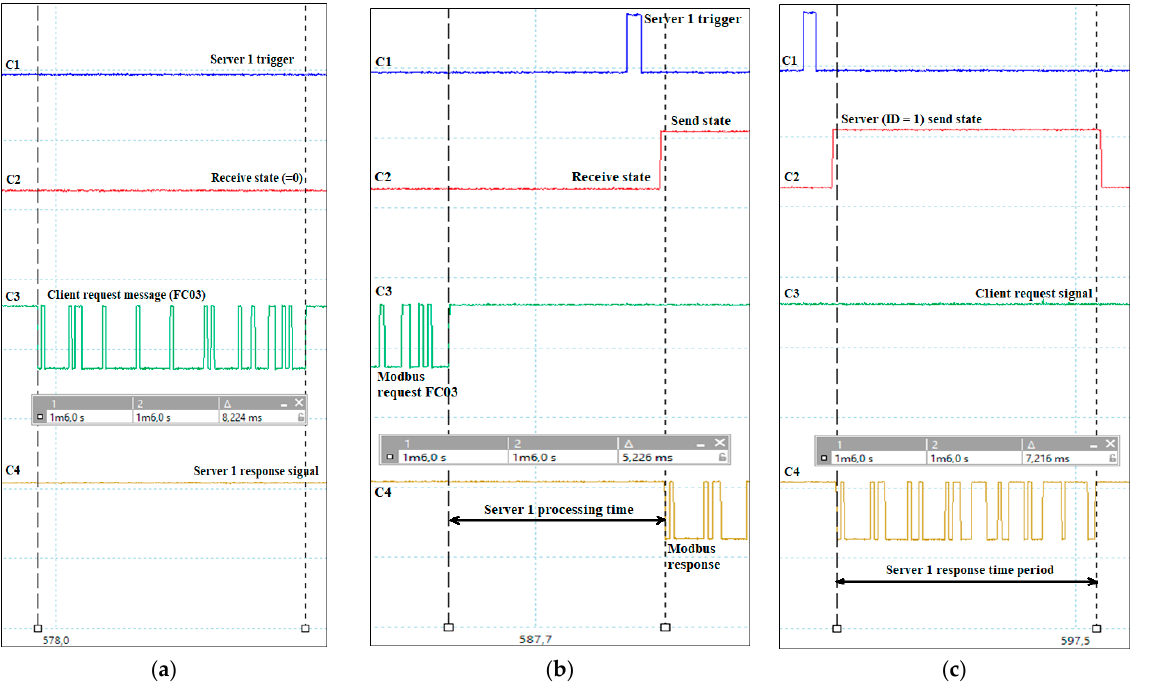
Figure 5. Modbus protocol experimental tests: ( a ) server query message timing with ID 0x01 and function FC03; ( b ) time required for processing at server with ID = 0x01 and FC03 (analysis of request and sending response; forced delay = 1 ms); ( c ) time required for response message of server with ID 0x01 and function